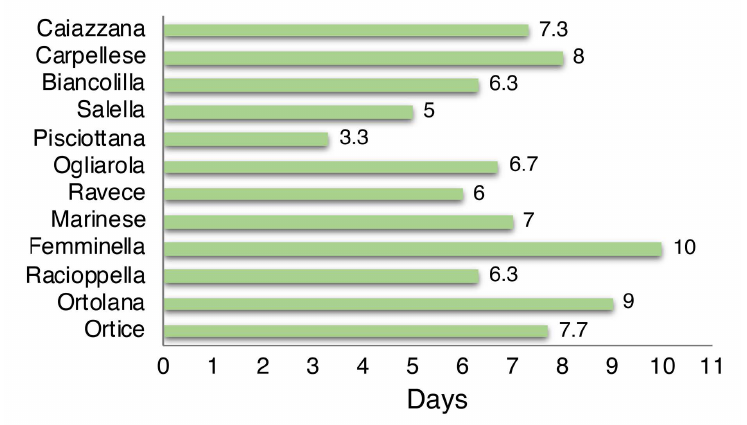
Figure 2. Duration of flowering in 12 olive cultivars from Campania region in Italy.